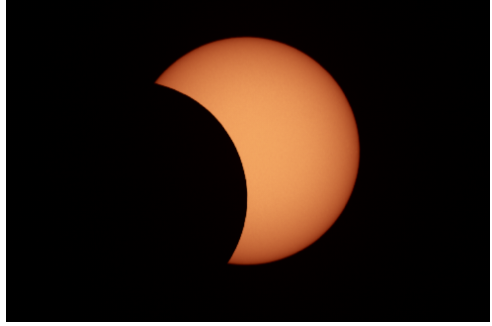
Figure 3: Image of a partial phase of the eclipse taken at 14:04 LT from Valcheta through a 200 mm f/5 Newtonian telescope, using a Canon 70D DSLR camera and a black-polymer. Note the darkening towards the limb of the